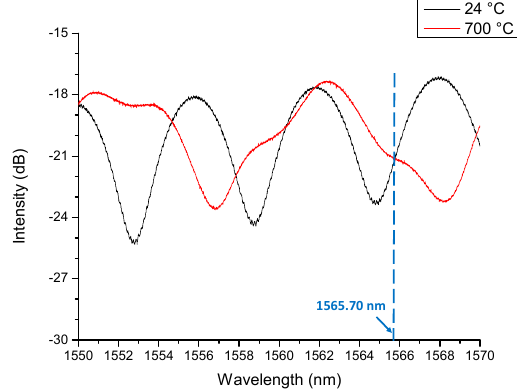
Figure 8. Experimental setup for the fiber optic ultrasonic sensing system high temperature test.